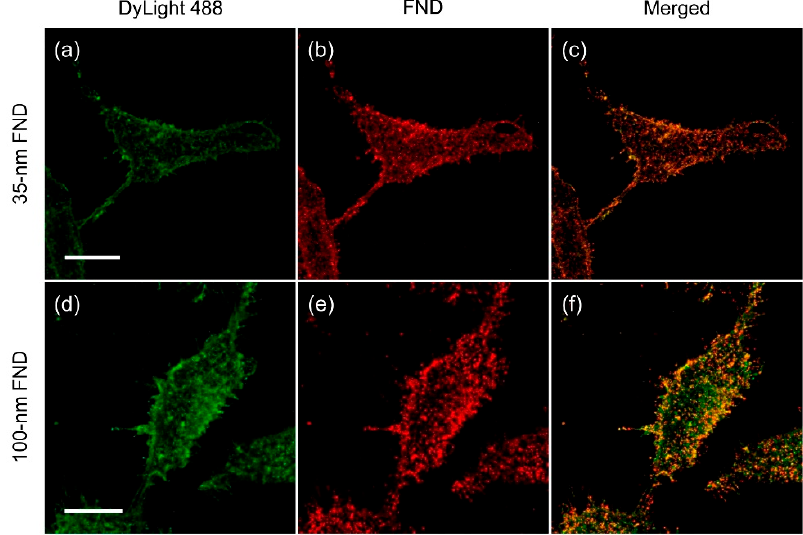
Figure 5. Co-localization studies with HeLa cells labeled with ( a – c ) 35 nm or ( d – f ) 100 nm bL-FNDs through sandwich immunostaining. The cells were first fixed and sequentially labeled with biotin-antiCD44 antibody, DyLight 488-NeutrAvidin (green), and bL-FNDs (red). Yellow spots in (c,f) indicate the co-localization of DyLight 488-NeutrAvidin (green) and bL-FNDs (red). The concentration of bL-FNDs used for the labeling was 100 μ g/mL. Scale bars: 20 μ m.